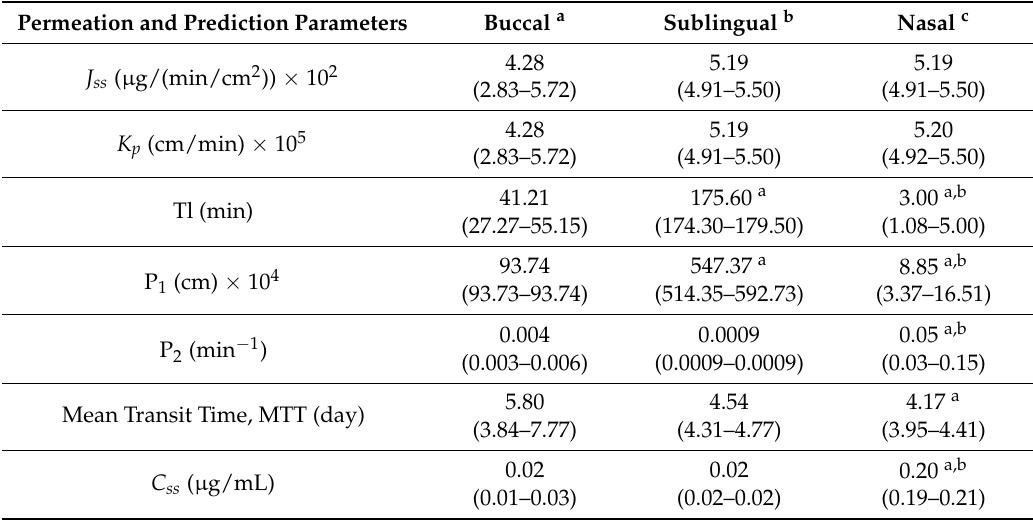
Table 2. Permeations and prediction parameters of different tissues with PGZ-NPs.